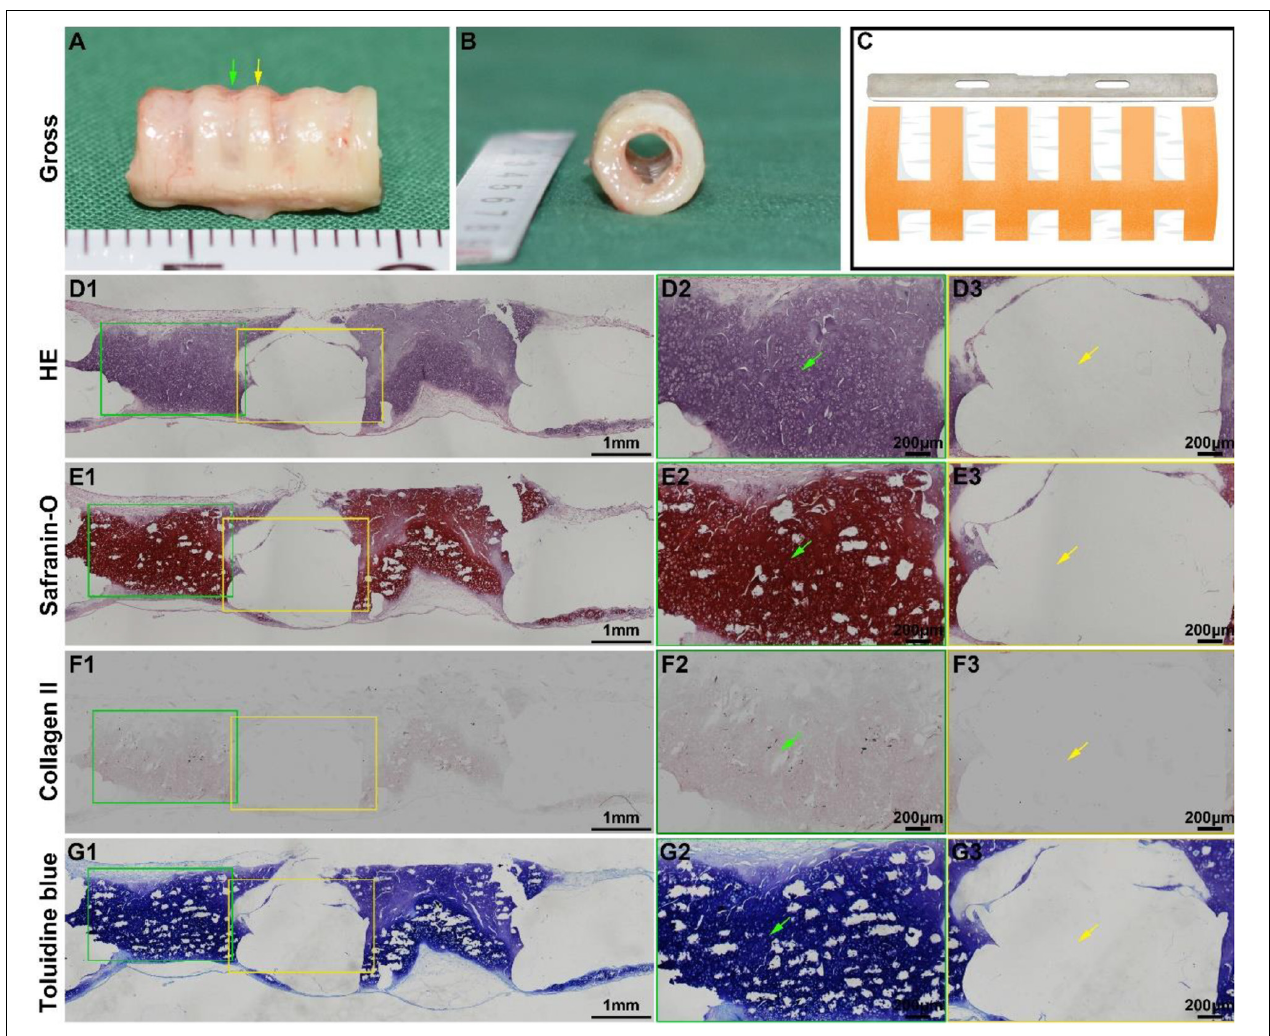
FIGURE 4 | In vivo biomimetic trachea formation and histological analysis of a longitudinal section. Gross view of the biomimetic trachea after 6 weeks in vivo incubation (A,B) . (C) shows the sectioning schematic. HE, safranin-O, collagen II, and toluidine blue staining of a longitudinal section of the engineered biomimetic trachea (D1–G1) . Magnified views of the cartilage ring (D2–G2) and PCL ring (D3–G3) . The green arrows indicate cartilage regions, and the yellow arrows indicate PCL